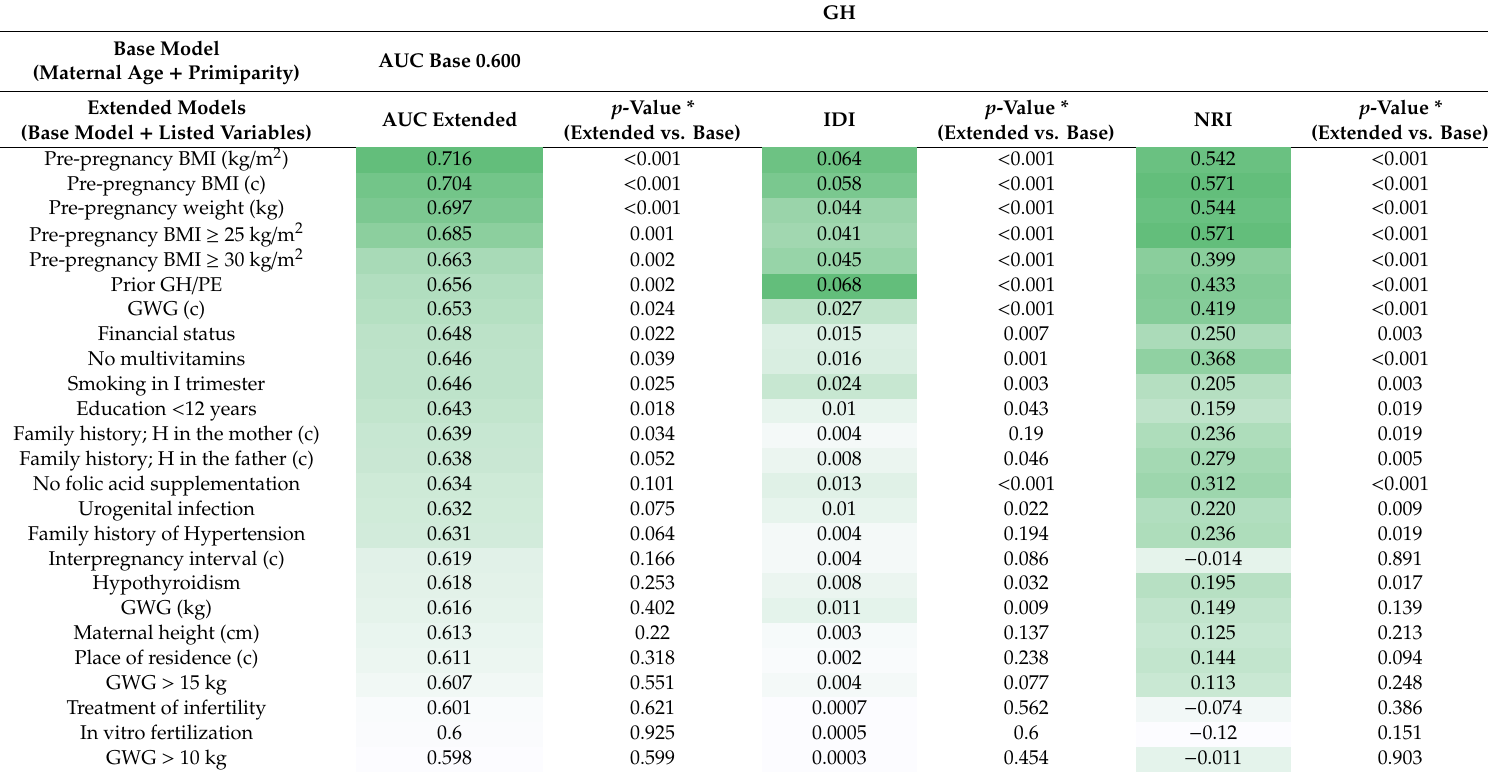
Urogenital infection